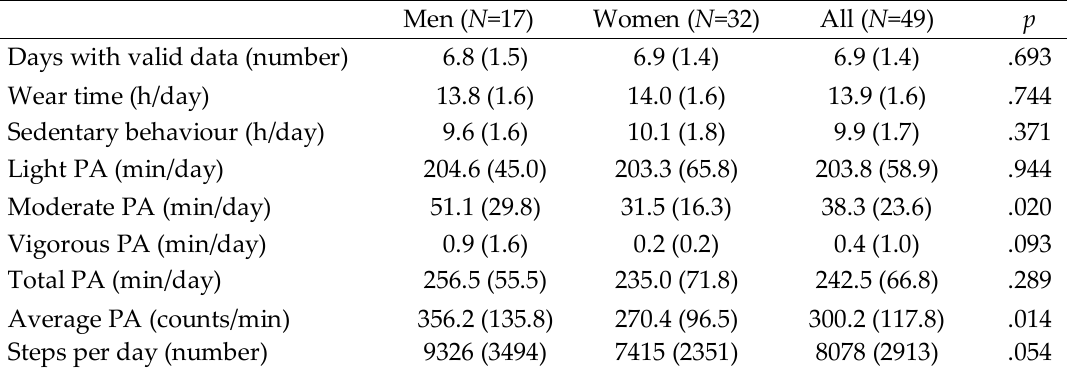
Table 2. Mean (standard deviation) of physical activity by accelerometer and t-test between genders